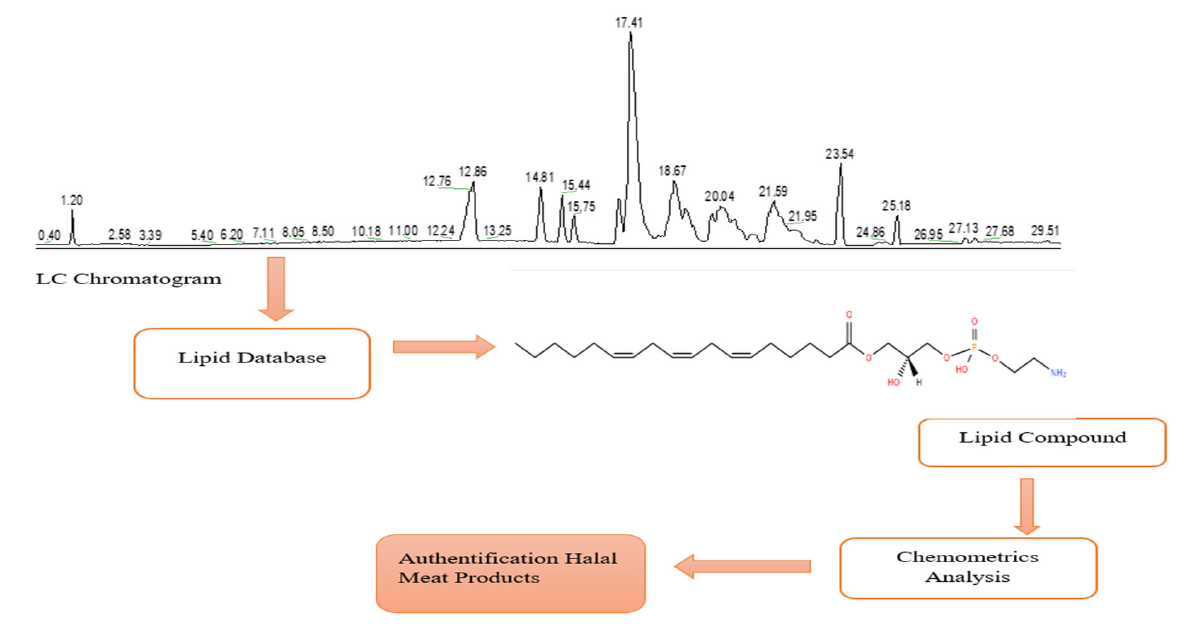
Figure 2. Data presentation of lipidomic study. Table 2. Chemometric applications in lipidomic studies for halal authentication of meat